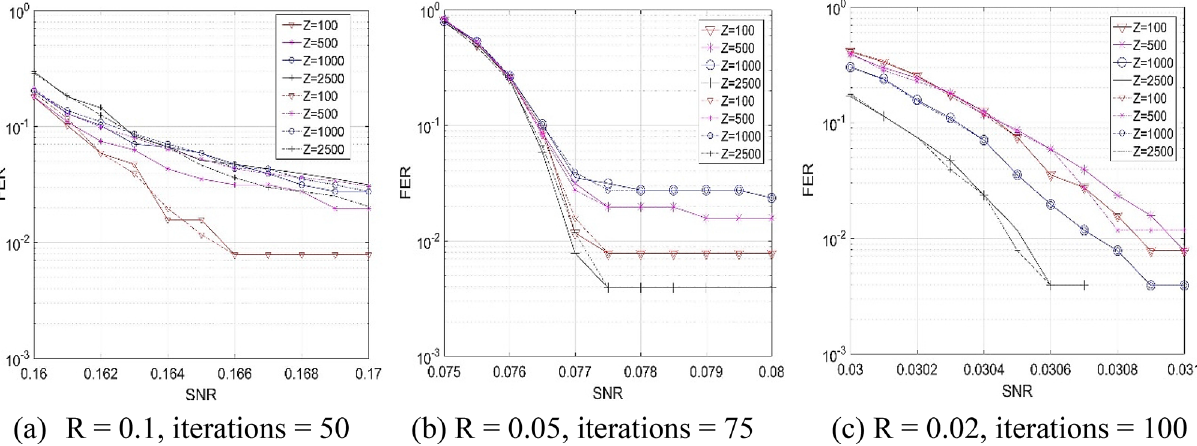
Figure 6. The FER vs SNR curves of the layered (solid lines) and the flooding (dot-dashed lines) decoders.